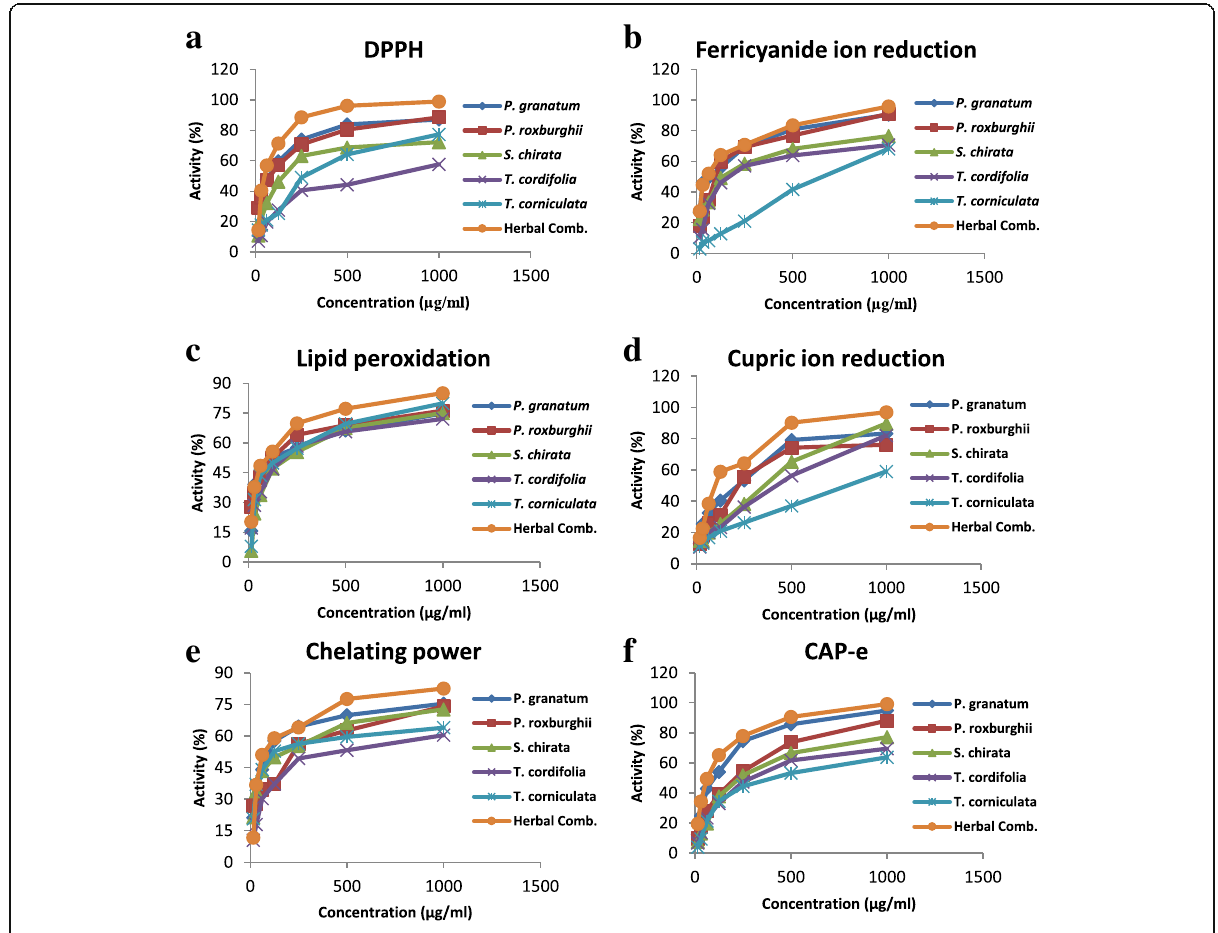
Fig. 1 In vitro antioxidant activity of five herbs and herbal